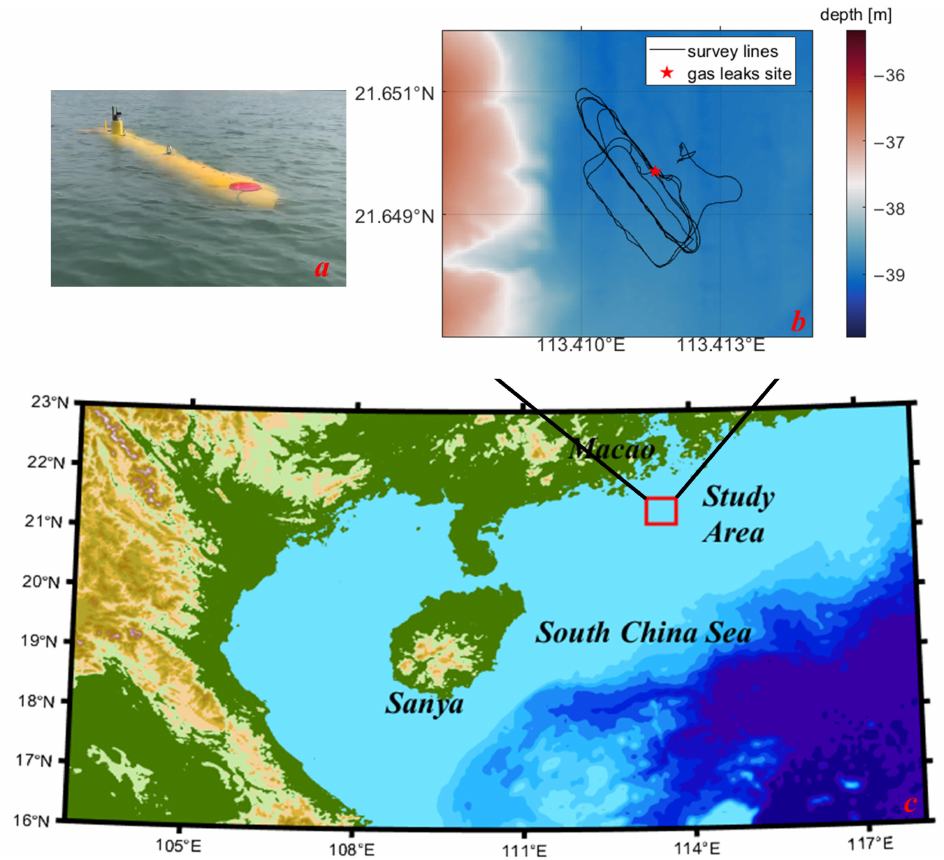
Figure 6. Study area, equipment, and survey lines. ( a ) Autonomous underwater vehicle (AUV) equipped with multibeam sonar. ( b ) Survey lines (black lines) of the AUV in the study area, where the red star indicates the location of the gas leakage site. ( c ) Position of the study area in the South China Sea, where the red rectangle indicates the multibeam sonar survey